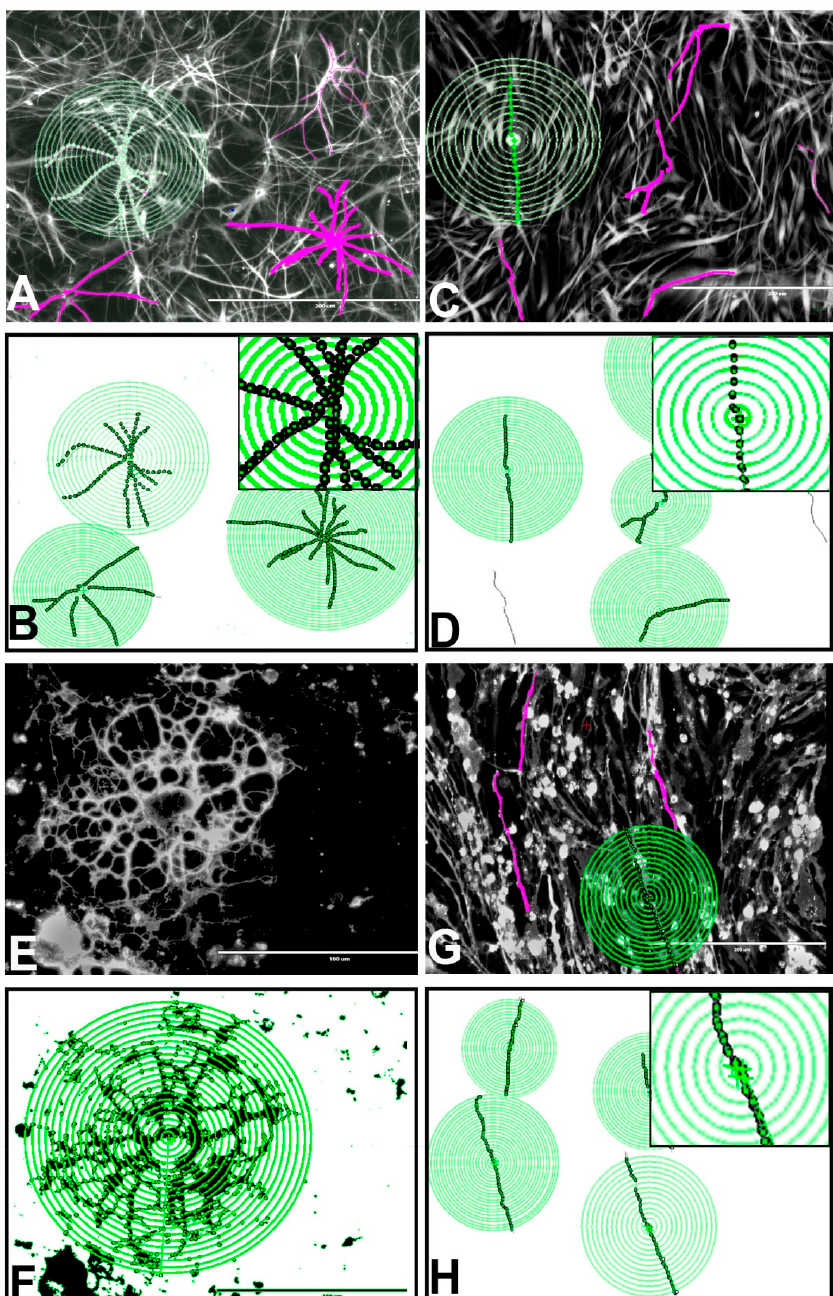
Figure 8. Effects of BPA or BPF treated for seven days on morphological changes of astrocytes and oligodendrocytes differentiated from rNSCs in relevant cell-specific directed differentiation medium. Differentiated astrocytes and oligodendrocytes were visualized with specific protein-marker GFAP and mGalc, respectively, and nuclei stained with DAPI. Fluorescent signals were segmented using the threshold tool and converted to binary mask for tracing complete cell morphology. Representative overlapped image of the rNSC differentiated into astrocytes in the absence of BPF ( A —control) and the presence of 100 µ M BPF ( C ). Relevant “Sholl analysis binary images” of traced astrocytes in the absence of BPF ( B —control) and the presence of 100 µ M BPF ( D ). Traced astrocytes with “simple neurite tracer” are in pink. Representative image of the rNSC differentiated into oligodendrocytes in the absence of BPA ( E —control) and the presence of 100 µ M BPA ( G ). Relevant “Sholl analysis binary images” of traced oligodendrocytes in the absence of BPA ( F —control) and the presence of 100 µ M BPA ( H ). Scale bar indicates 200 µ m at 20 ×